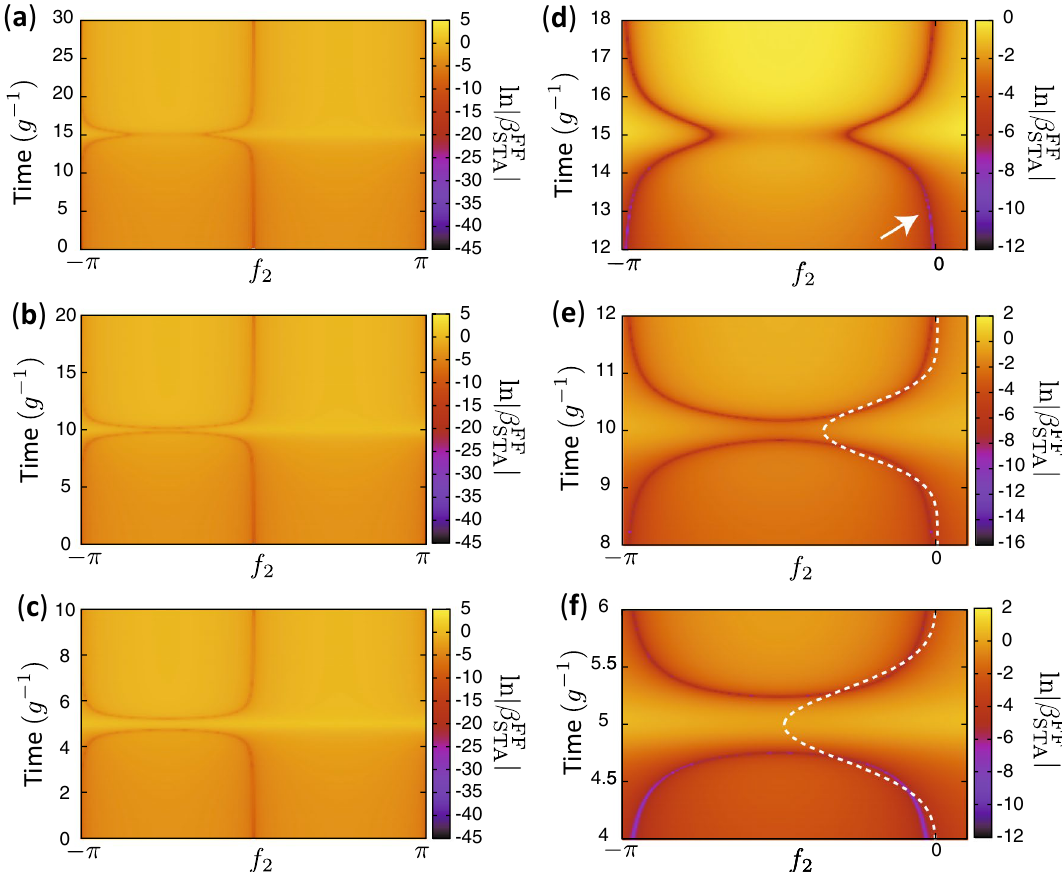
Figure 3. Inter-trajectory travel for shortcuts to adiabaticity. ( a–c ) ln | β FF STA | as a function of f 2 and t . ( a–c ) are for T F = 30 g − 1 , 20 g − 1 and 10 g − 1 , respectively. ( d–f ) are the closeups of panels ( a–c ) respectively. The arrow in ( d ) indicates the speed-controlled trajectory. The white dashed curve in panels ( e,f ) shows a virtual trajectory. �ω 0 = 30 g , where g is